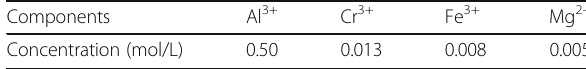
Table 2 The components of chromium-containing